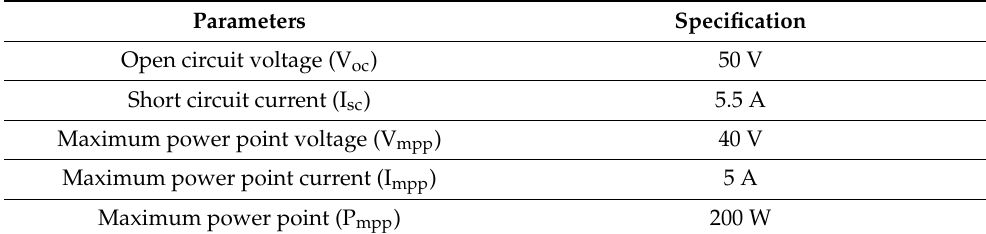
Table 3. The solar PV simulator specification.